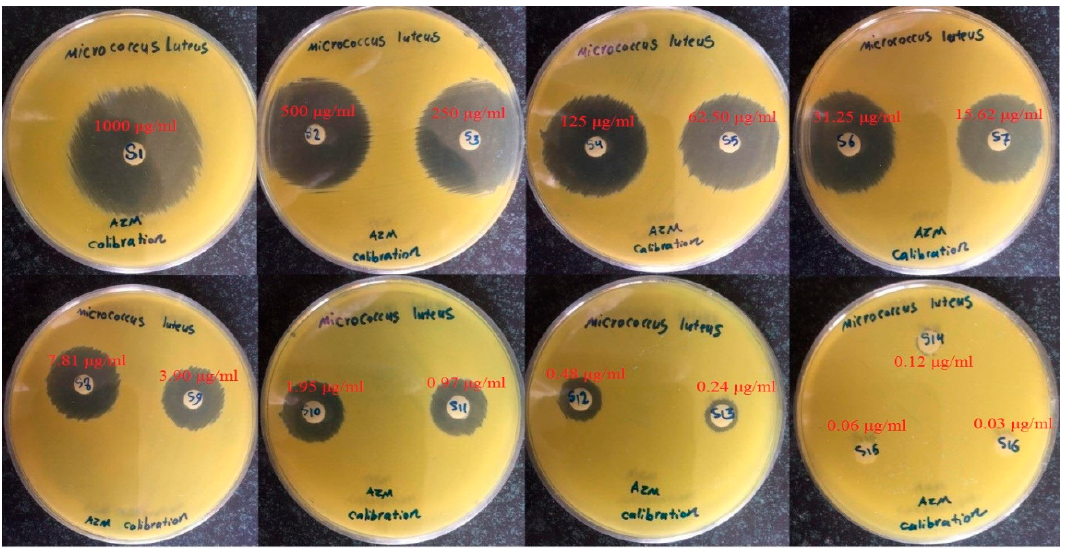
Figure 7. Zone of growth inhibition by Micrococcus luteus in the analysis of azithromycin.